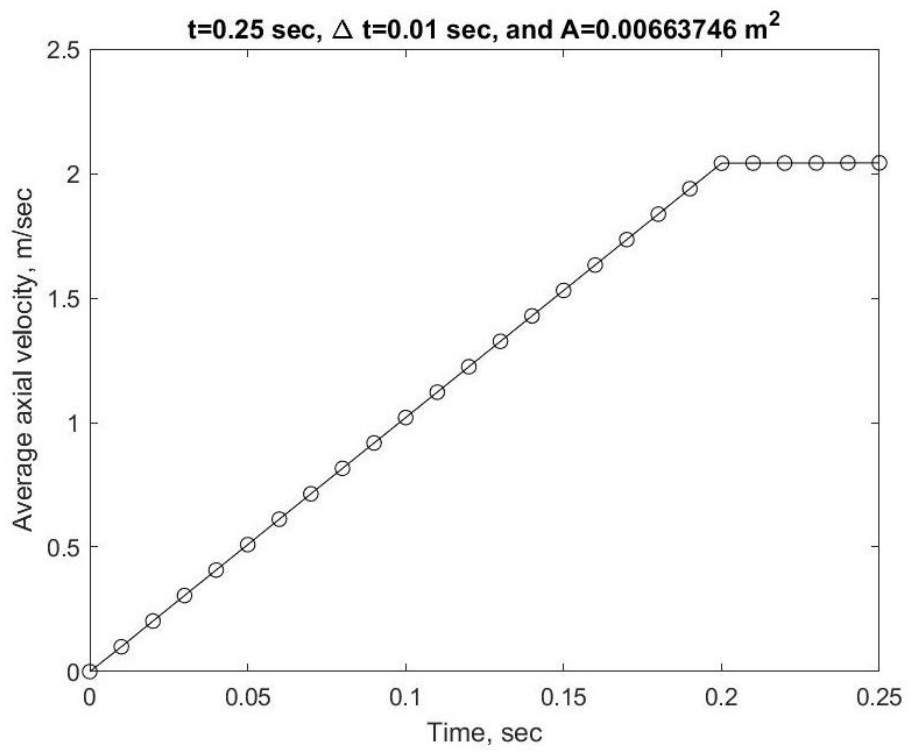
Figure 10. Average velocity at the flow exit around 0.5 m from the inlets in ADINA modeling as a function of